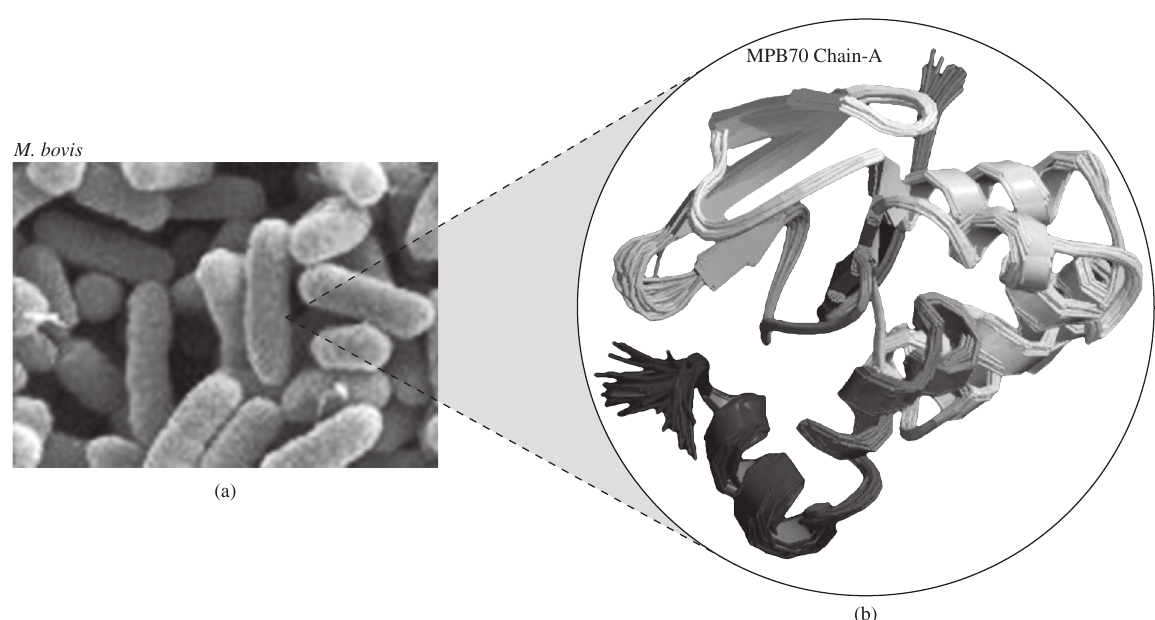
Figure 1. Mycobacterium tuberculosis ; Solution Structure of the Antigenic Tb Protein MPT70/MPB70; Authors: M. J. Bloemink, E. Dentten, R. G. Hewinson, R. A. Williamson, M. D. Carr; Exp. Method: NMR, Polymer Chains: A; Residues: 163; Source: The RCSB Protein Data